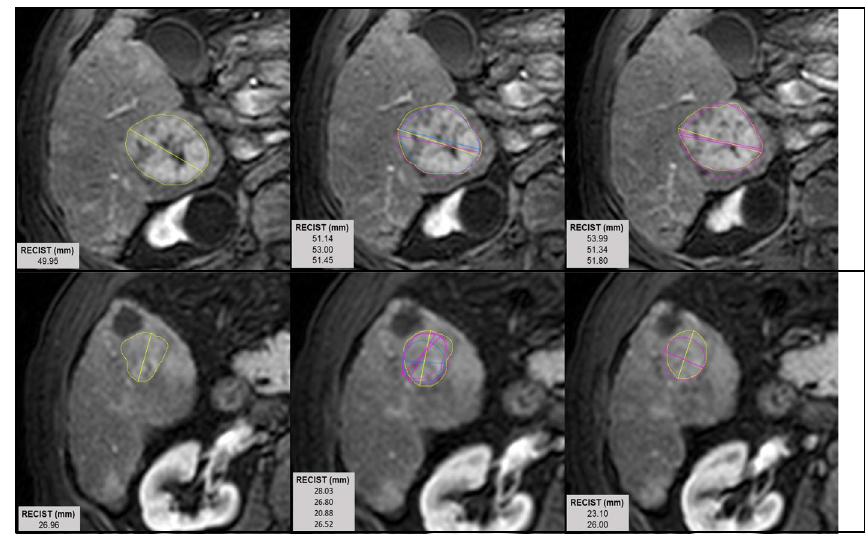
Fig. 3 Radiologist-defined RECIST measurements on two example lesions: Lesion codes 19.2 (top row) and 19.3 (bottom row). Radiologists were free to choose the MRI slice on which they indicated the diameter. Within each row, each of the three images depicts a different MRI slice. Diameters drawn by the same radiologist are indicated in the same color (Pink Lesion contours are included for context. Each image is displayed in the optimum visualization window and phase used for